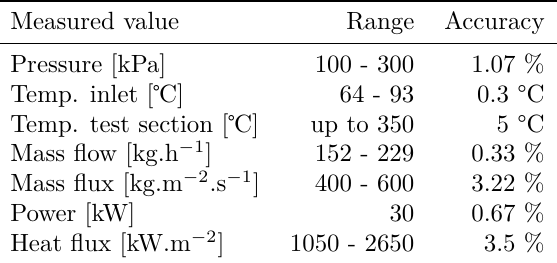
Figure 3. From left to the top is a design and its actual photography of the first, the second and the third version of measurement probe.